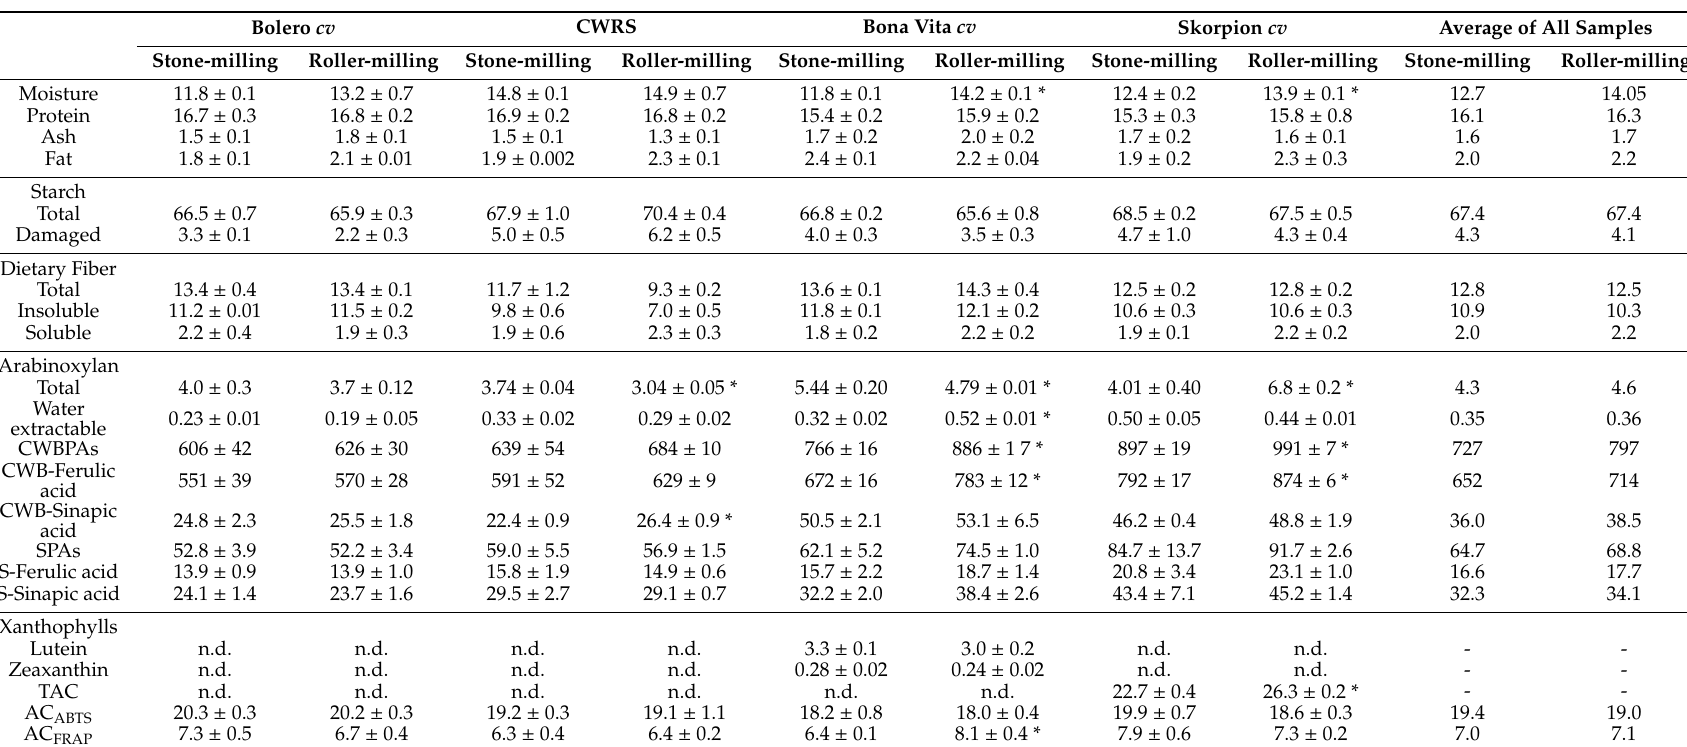
Protein, ash, fat, total dietary fiber and total arabinoxylans values are expressed as g / 100 g dry basis. Damaged starch is expressed as g / 100 g of total starch. Insoluble and soluble dietary fiber are reported as g / 100 g dry basis of total dietary fiber. Water-extractable arabinoxylans are expressed as g / 100 g dry basis the total arabinoxylans. Cell wall-bound phenolic acids (CWBPAs) and soluble (free and conjugated forms) phenolic acids (SPAs) are the sum of the single phenolic acids determined by means of RP-HPLC / DAD and are expressed as mg / kg dry basis. Xanthophyll (lutein and zeaxanthin) are expressed as mg / kg dry basis. Total anthocyanin content (TAC) is expressed as mg Cy-3-glc eq / kg dry basis. Antioxidant capacity (AC) measured by means of the ABTS and FRAP assays is expressed as mmol TE / kg dry basis. CWRS: commercial Canada Western Red Spring Wheat. Data are presented as mean ± standard deviation. The asterisks indicate significant di ff erences between the means of stone- and roller-milled samples of each cv (* p < 0.01). The absence of asterisk indicates a not